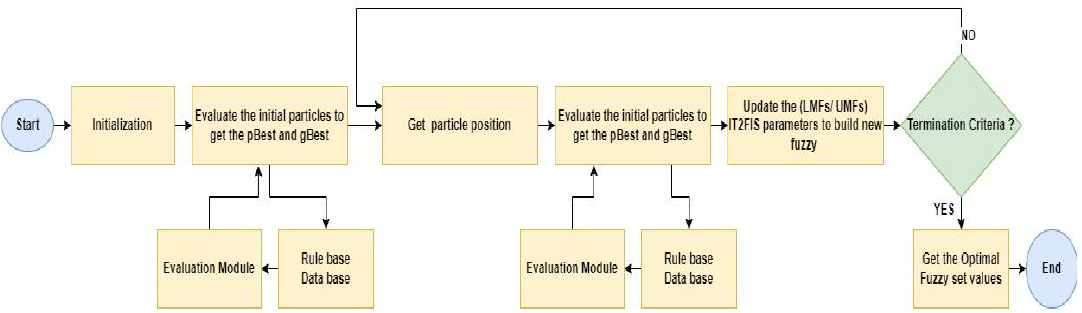
Fig. 1. Flowchart of the fuzzy membership function optimized with PSO.